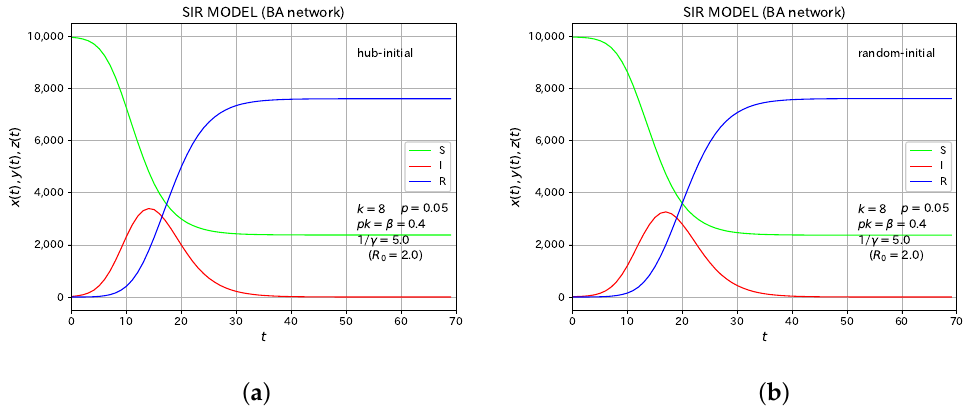
Figure 9. The simulational results of the microscopic SIR model on the BA network. Initial infected individuals are different. ( a ) The first 10 infected individuals are within the hub. ( b ) The first 10 infected individuals are outside the hub. For both cases, the average over 40 samples was taken.